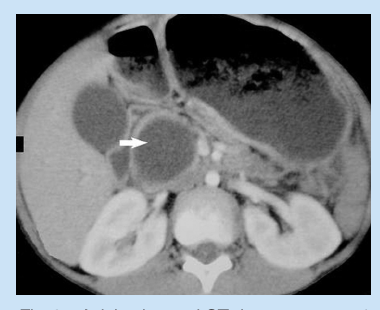
(star).Fig.2a.Axial enhanced CT demonstrates a 4 × 2 cm type 1 hyatid cyst in the pancreas (arrow). The dilated debris-filled stomach and compressed second part of the duodenum are also